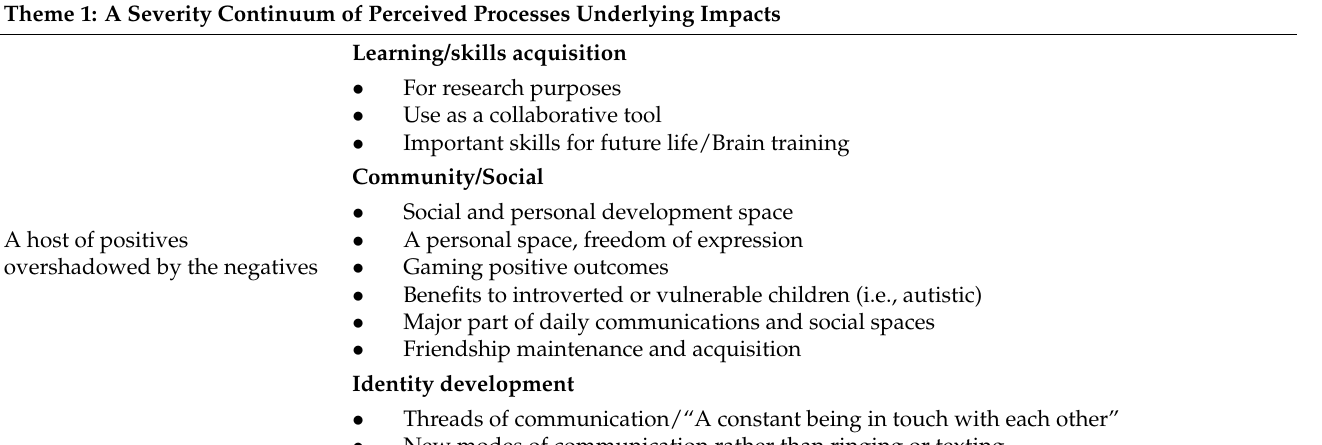
Table 1. Stakeholder perceived impacts and